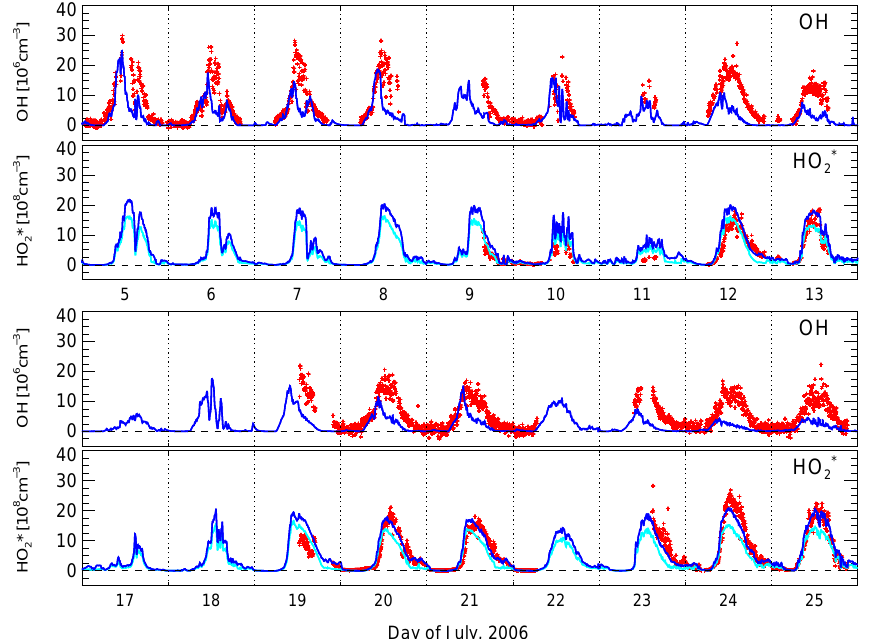
Fig. 4. Time series of 5min-averaged measured and simulated (M0) concentrations of OH and HO ∗ 2 at the Backgarden site during PRIDE-PRD2006 campaign. Experimental values are denoted by red symbols, modelled values by blue lines. Modelled values of HO 2 are represented by cyan lines. The difference between the lines for HO 2 and HO ∗ 2 is the interference by RO 2 calculated by the base model (RACM-MIM-GK). Vertical dotted lines denote midnight.